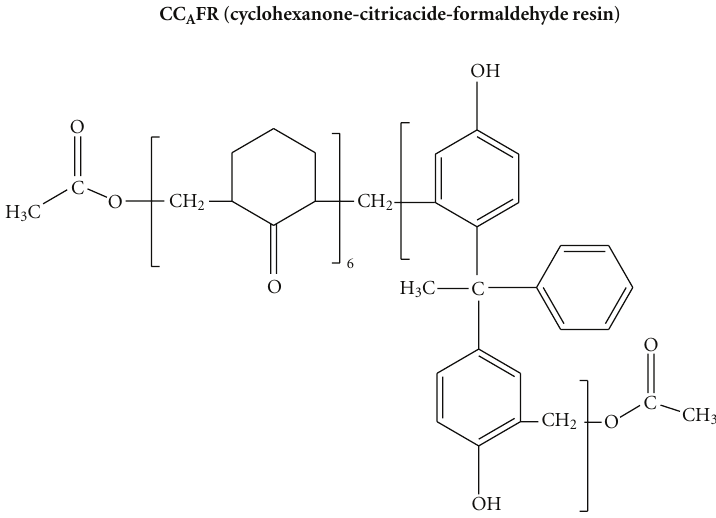
anodic reaction by acting as a barrier layer between electrode surface and corrosion